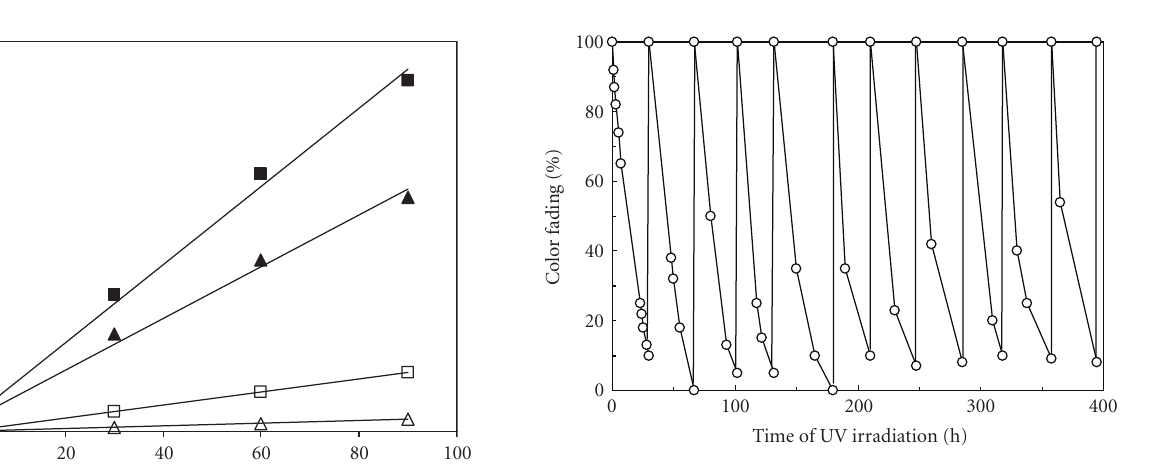
Figure 6: Color fading of MB solution under UV irradiation in the presence of carbon-coated TiO 2 sample (10wt% of carbon) with cycling to use fresh MB solution, concentration of MB = 2.94 × 10 − 5